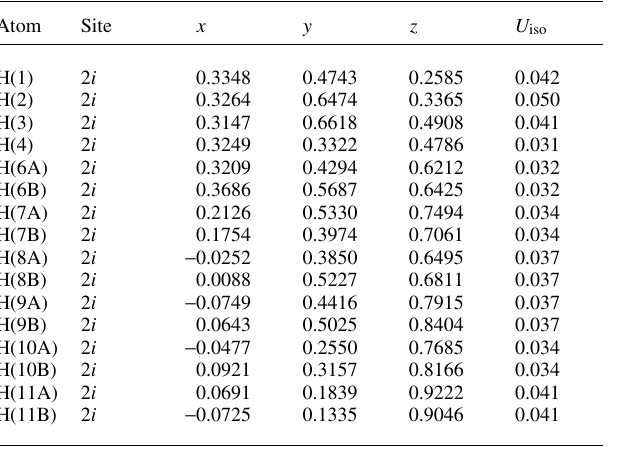
Table 2. Atomic coordinates and displacement parameters (in Å 2 )